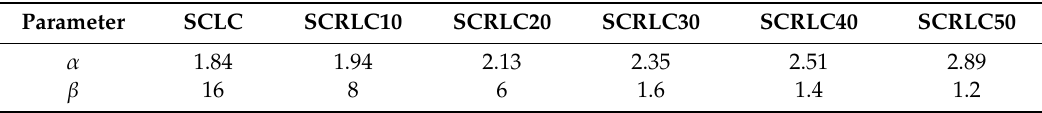
Figure 8. Whole curve of strain–stress under uniaxial compressive. Table 6. Parameters α and β for strain–stress curves of self-compacting rubber lightweight aggregate concrete (SCRLC).